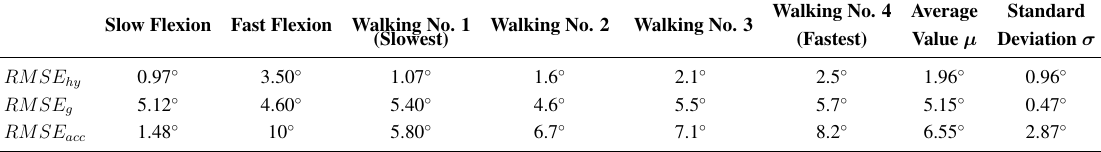
Figure 6. Dynamic comparison between our estimation technique and the reference measurement during walking at different velocities. Velocities increase from ( a ) to ( d ). The blue line represents our estimation, while the red line is the reference measurement. Table 1. Root mean square errors (RMSEs) obtained in the six trials for the various estimation methods. The first row ( RMSE ) reports the errors of the hybrid system by hy applying the fusion technique described in this paper. The second and third rows show the textile goniometer ( RMSE ) and accelerometer ( RMSE ) errors. The last two columns g acc report the mean and standard deviation of the RMSE across the trials for the different measurement